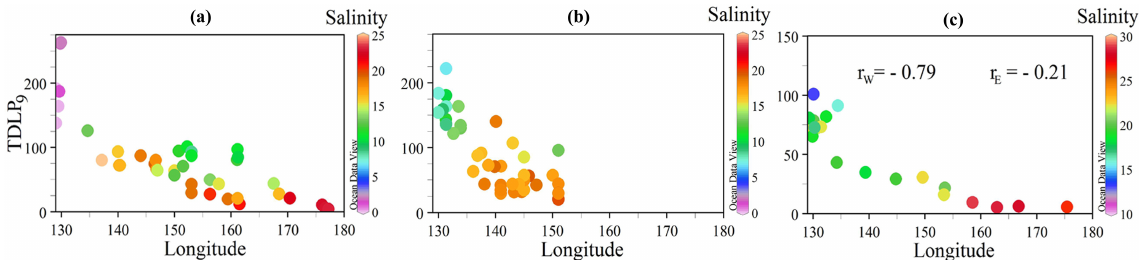
Figure 7. The relationship between the dissolved lignin concentrations (TDLP 9 , nmolL − 1 ) and salinity in the ESAS surface waters, Septem- ber 2004 (a) , 2005 (b) , and 2011 (c) , where r W and r E represent correlation coefficients between TDLP 9 and salinity for western and eastern parts of the ESAS, respectively, for these three years